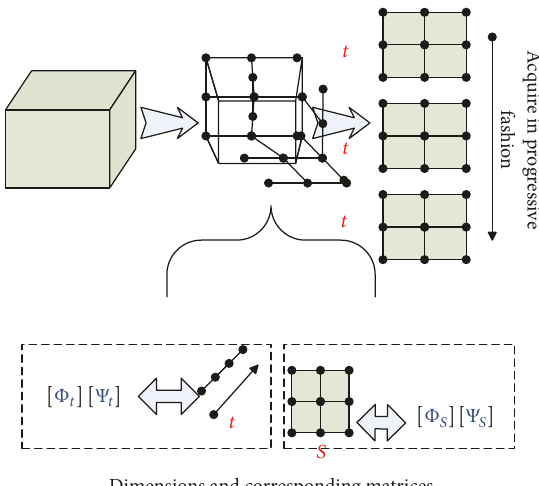
Figure 2: The proposed multidimensional compressive sensing for video acquisition.